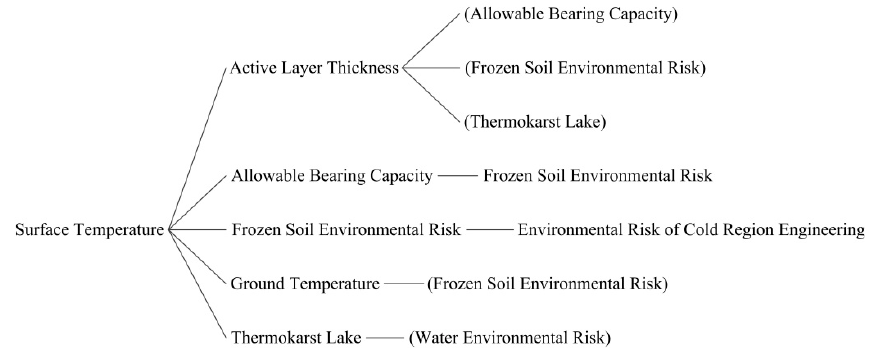
Figure 4. The uses’ tree of the surface temperature.